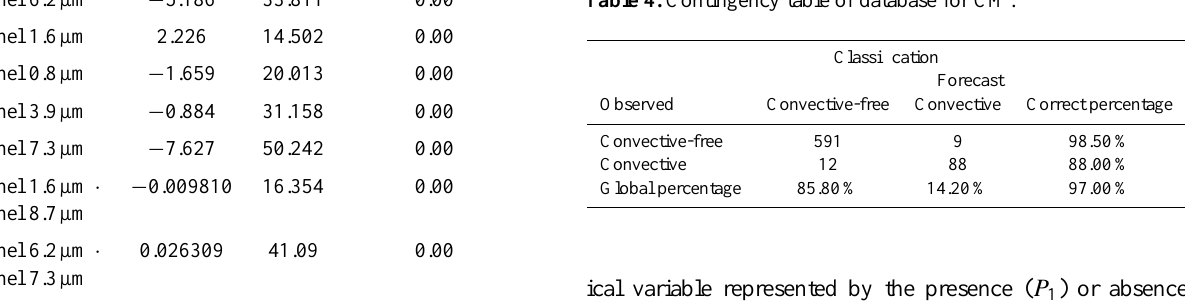
Table 4. Contingency table of database for